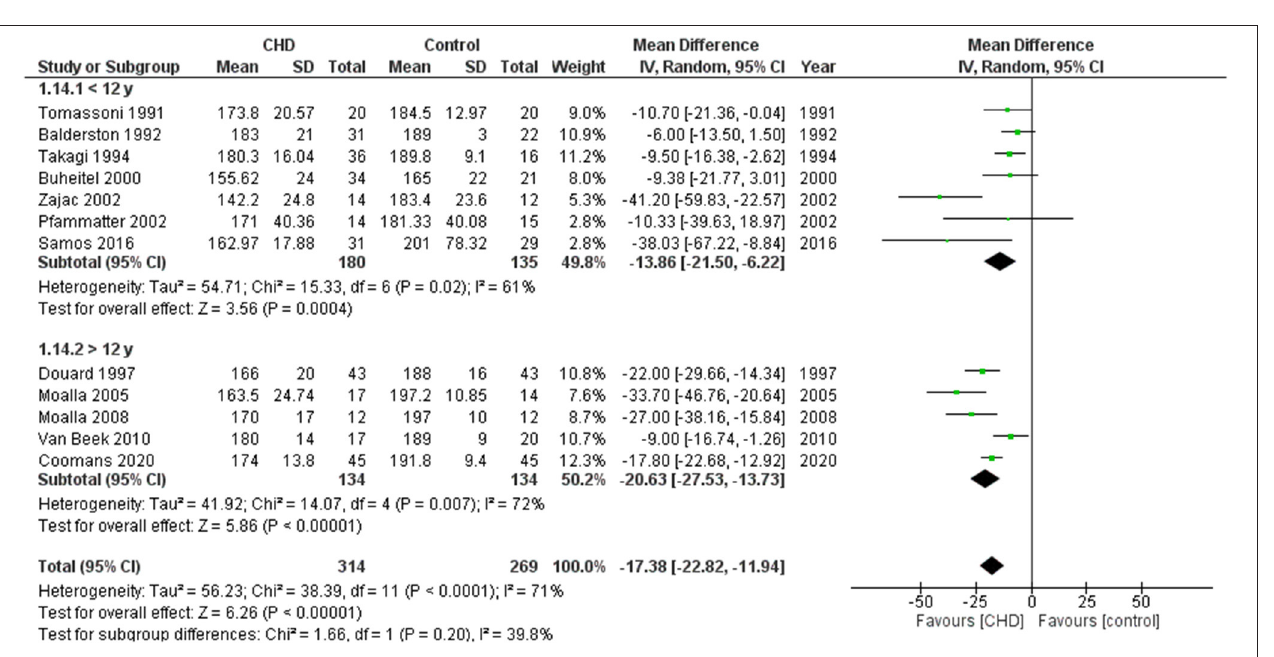
capacity, morbidity and mortality and is a prognostic factor in this population, reaching clinical and functional relevance. The